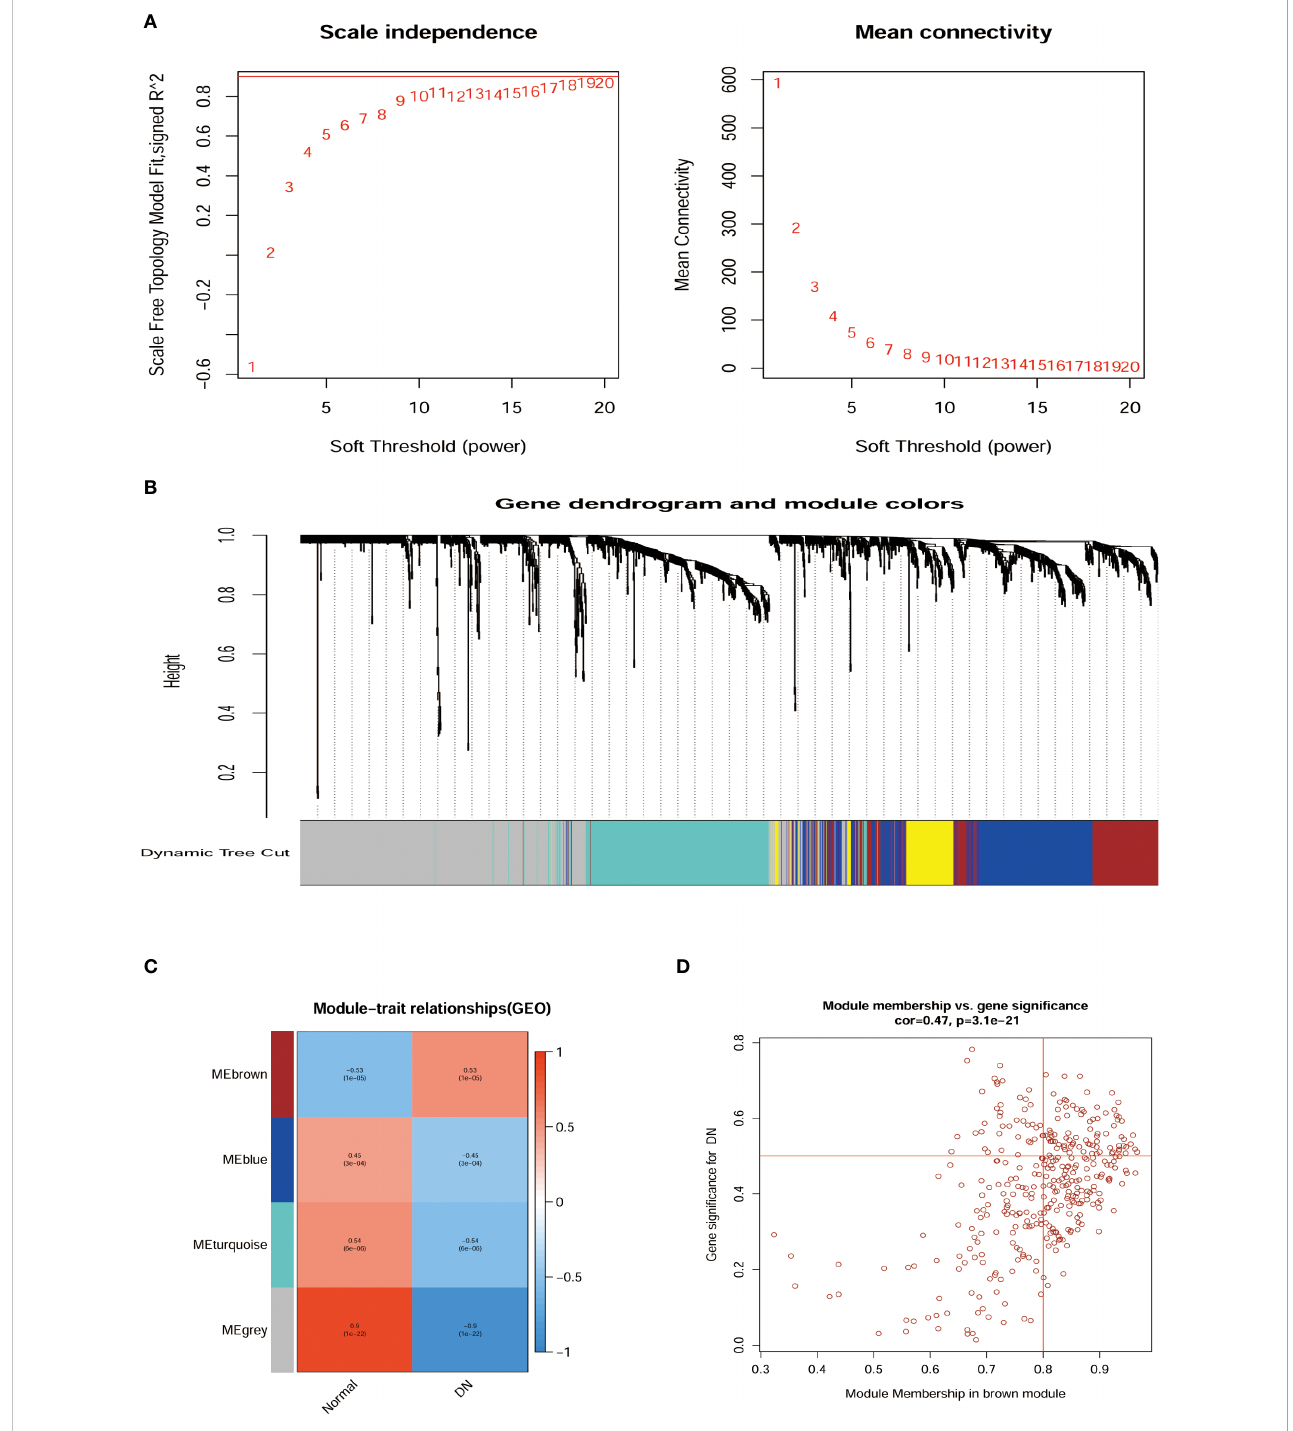
FIGURE 3 Relationship of hub gene modules and DN phenotypes by WGCNA. (A) Network topology analysis at different soft threshold powers and network connectivity validation at different weighting factors. (B) Cluster Dendrogram of modules colors were constructed with all the differentially expressed genes. (C) MEs correlated with diagnosis for DN. (D) Scatterplots of gene signi fi cance for DN Module membership in brown module. ME, Module eigengenes; WGCNA, weighted gene co-expression network